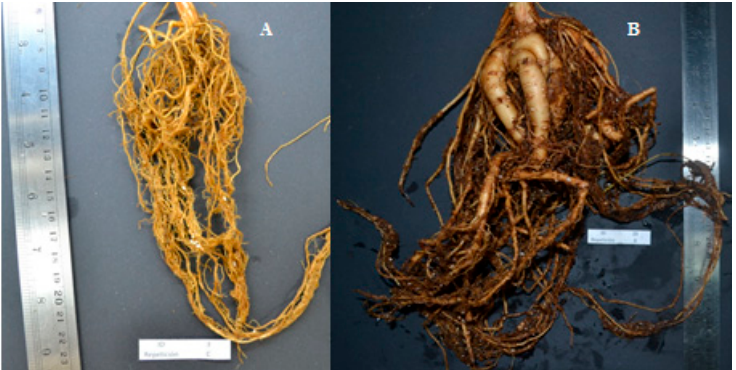
Figure 3. Root type present in P. coccineus . ( A ) A fibrous (fasciculated) root type belonging to line 3, and ( B ) a tuberous root type belonging to line 20.